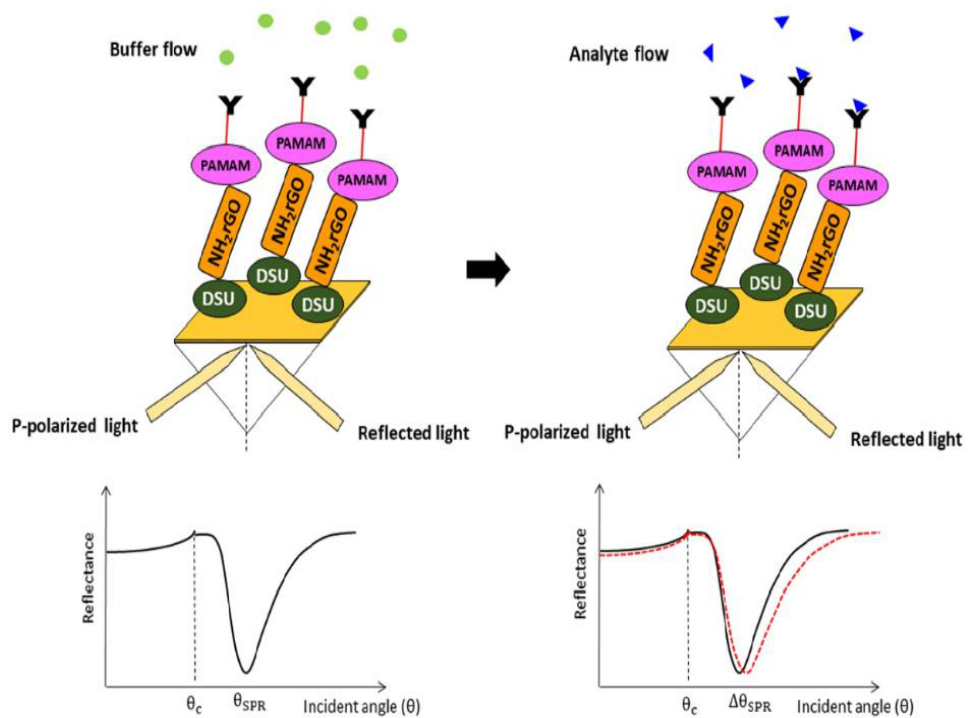
Figure 3. Schematic illustration of the SPR signal before and after the analyte flow. Reused with permission from Springer Nature [88].